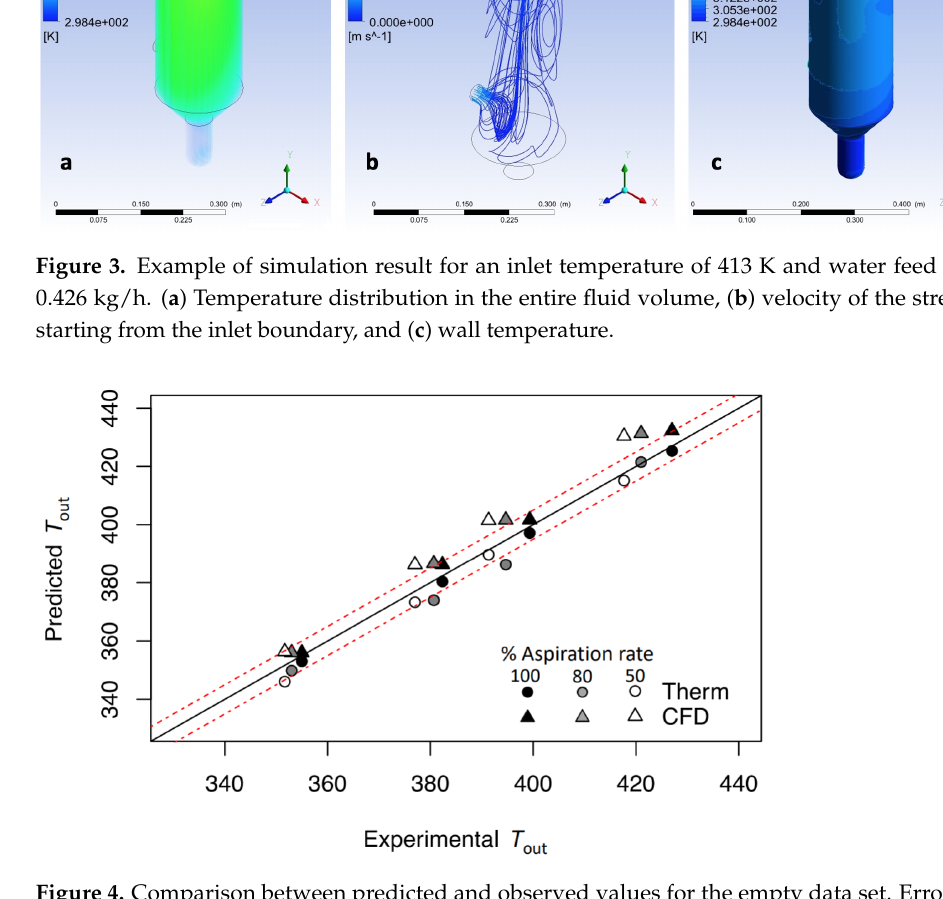
Figure 4. Comparison between predicted and observed values for the empty data set. Error bands are dashed in red at ± 5 K from the reference value (solid black